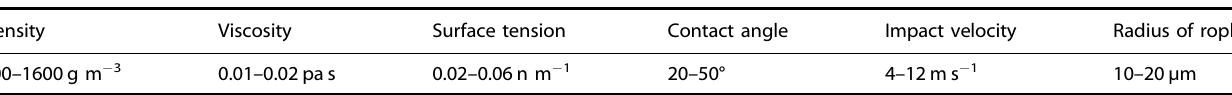
Table 1. Parameters of ink droplet set in